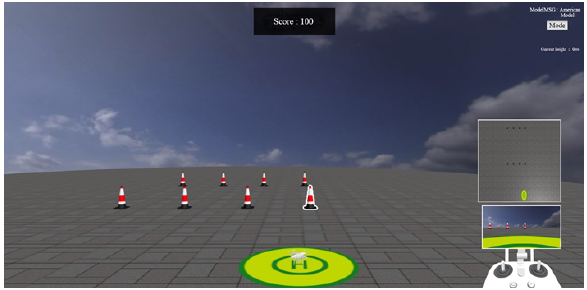
Figure 8. UAV virtual simulation